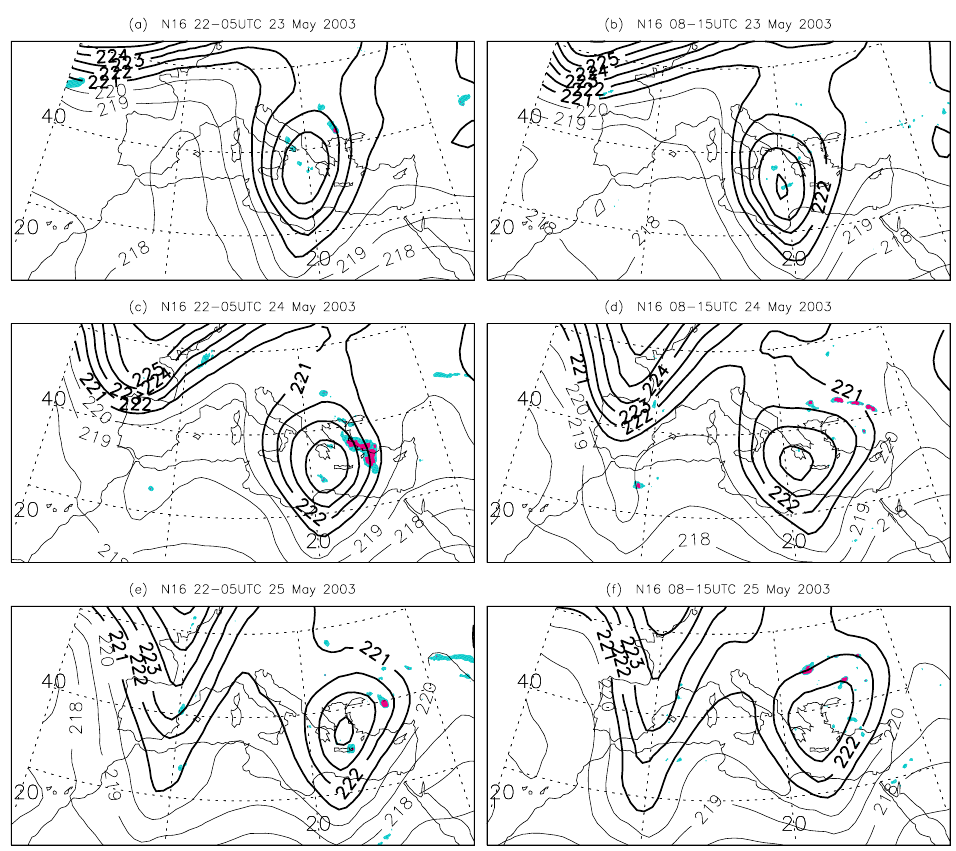
Fig. 9. Same as Fig. 4 but for 23–25 May 2003, (a, c, e) descending (22:00–03:00UTC), and (b, d, f) ascending (08:00–13:00UTC).